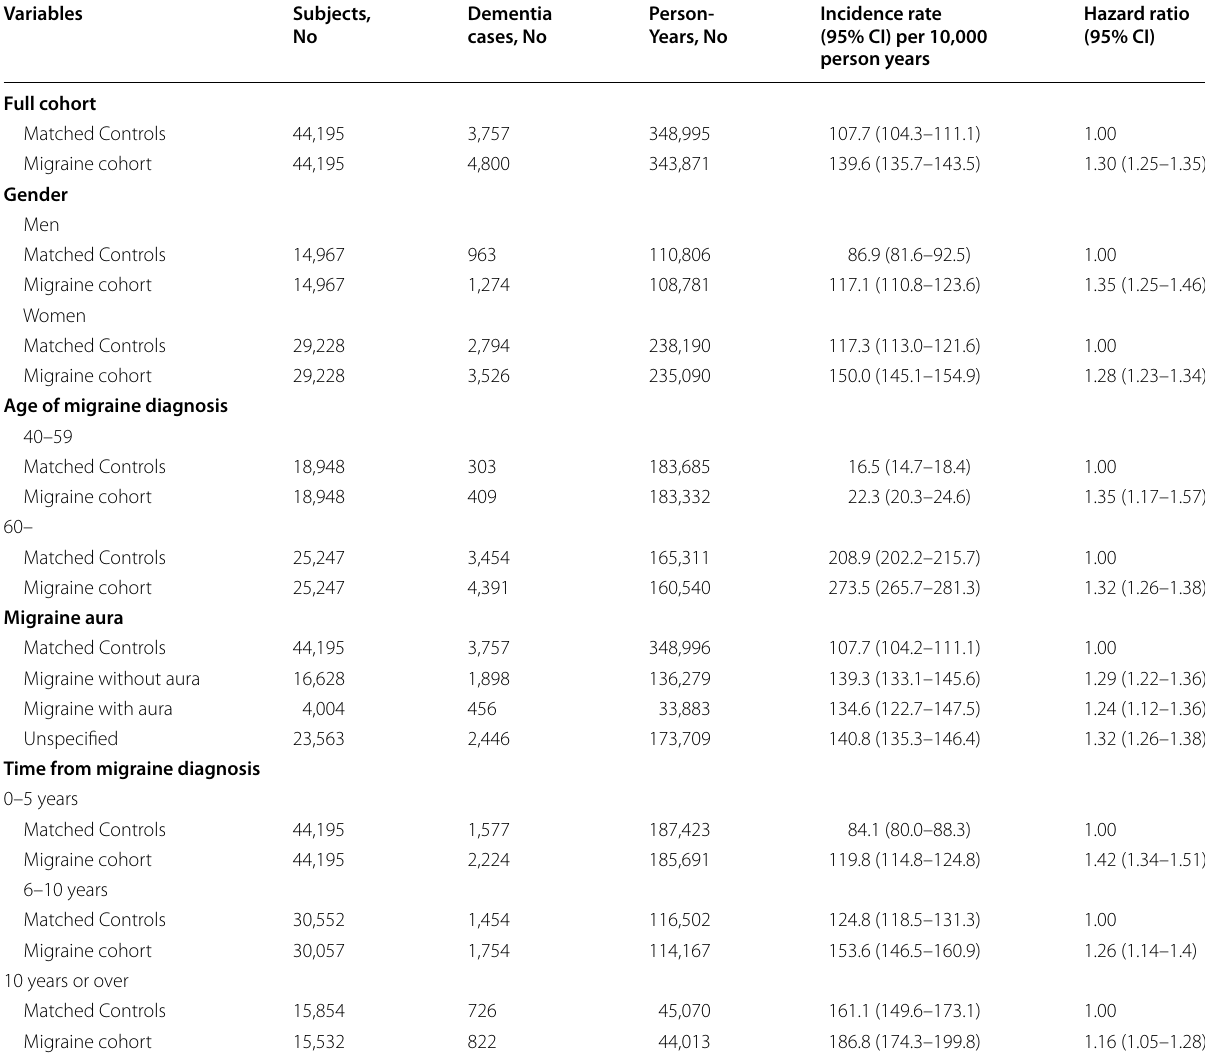
Table 2 Comparable analysis for the association between migraine and the risk of all‑cause dementia Variables Subjects,